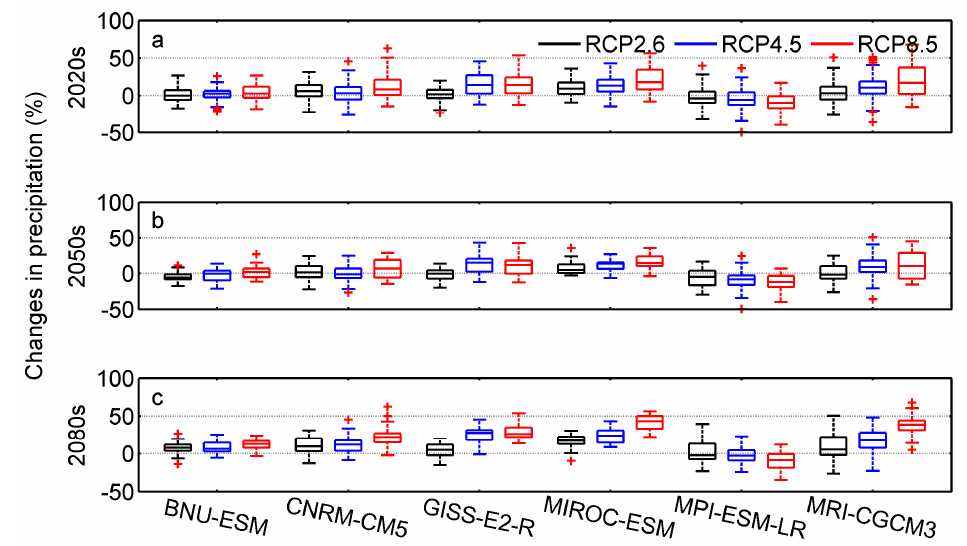
Figure 7. Box plots of change ratios in annual precipitation (%) in the future periods (( a ) 2020s, ( b ) 2050s and ( c ) 2080s) under RCPs (RCP2.6, RCP4.5 and RCP8.5).